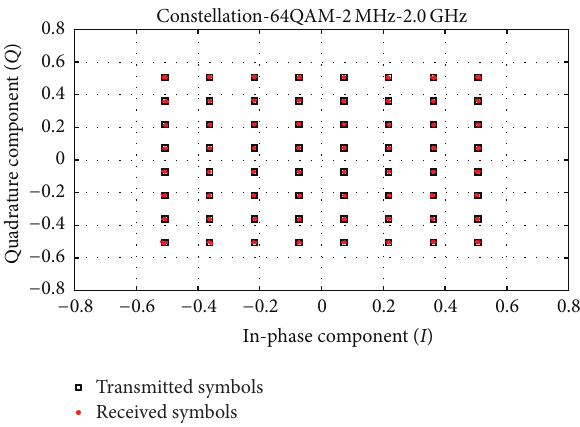
Figure 9: Transmitted and received frequency spectrums of a 64- QAM signal having 2MHz bandwidth for six-port-based receiver